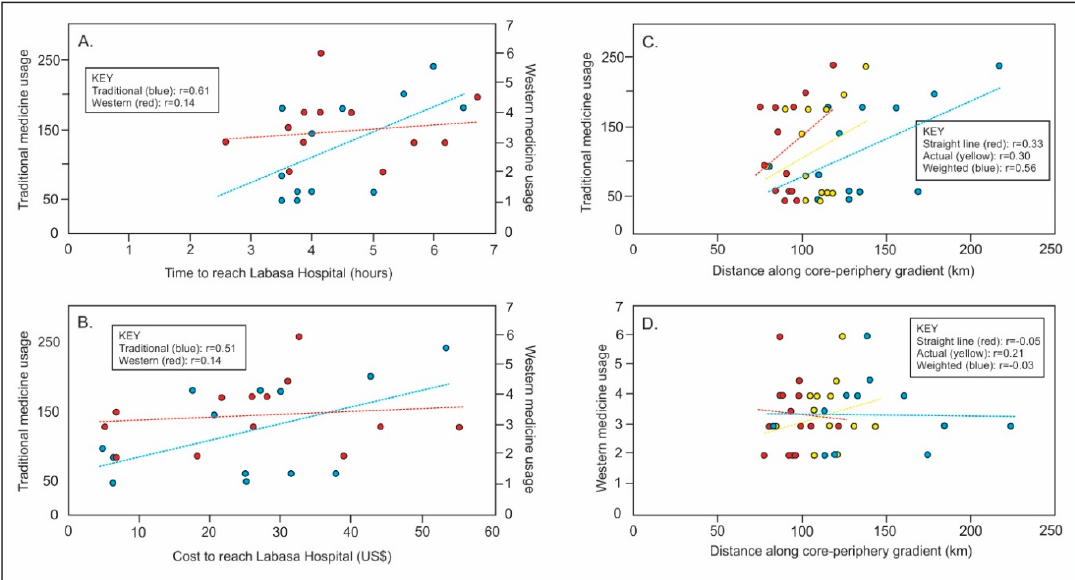
Figure A2. Graphs illustrating the comparative usage of traditional and ‘western’ medicines in the communities of Bua. Graphs ( A , B ) show that there is a strong relationship between traditional medicine usage and peripherality (as measured respectively by time and cost involved in reaching the full-service hospital in Labasa). This relationship is borne out by the correlations between the three distance measures and traditional medicine use in Graph ( C ); note that the strongest relationship is with weighted distance. The absence of clear relationships between distance and ‘western’ medicine use (Graph D ) suggests the latter is not readily explainable by community peripherality, a conclusion also suggested by Graphs ( A and B) .